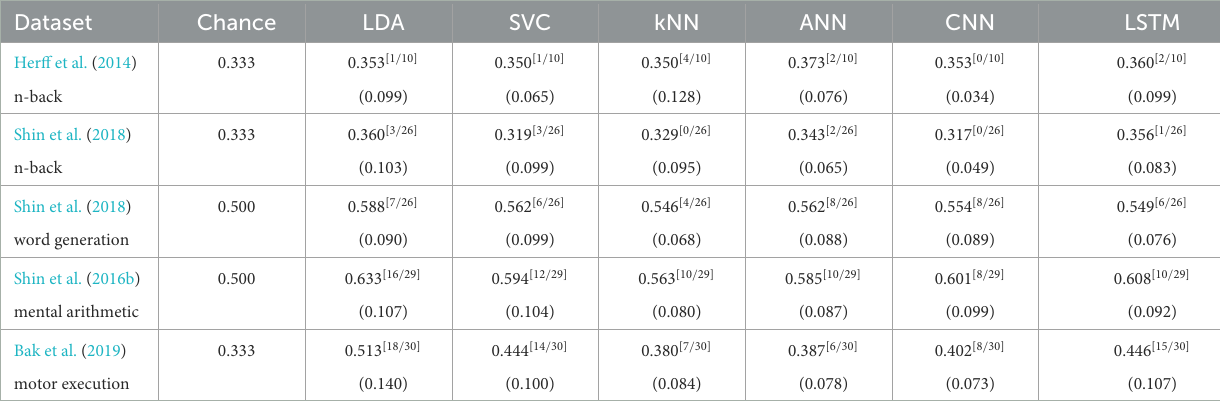
TABLE 5 Accuracies of the models on each dataset with the personalised approach.